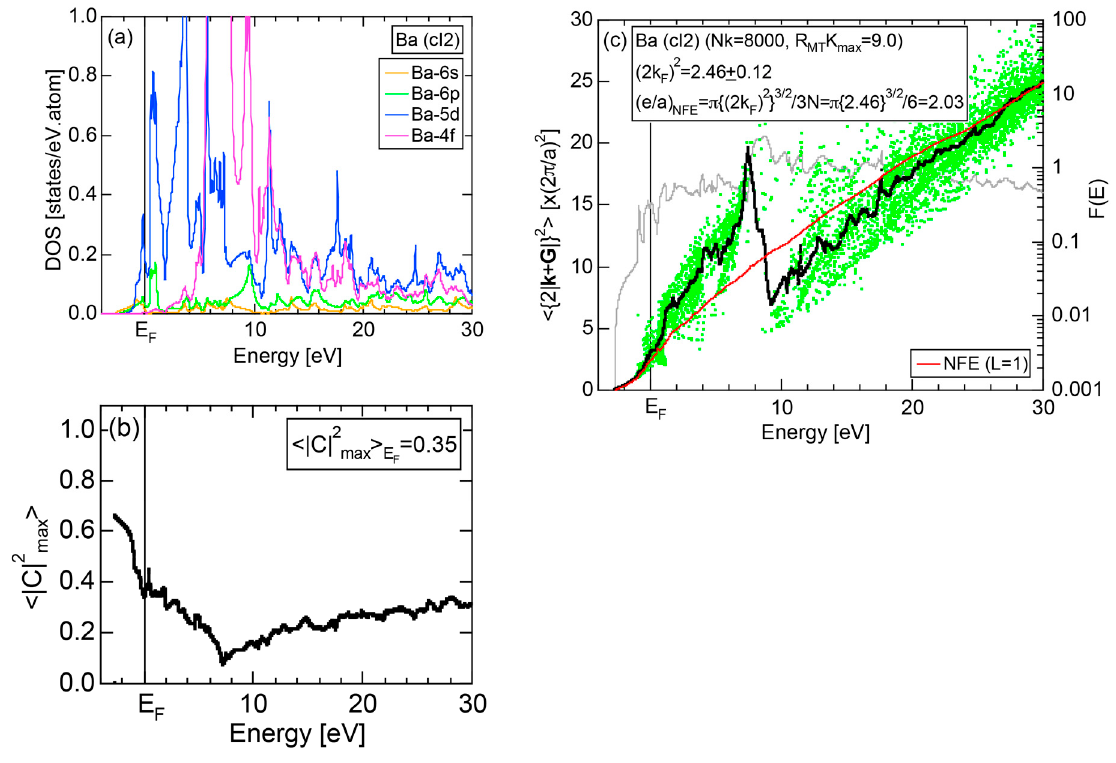
max2 and ( c ) Hume-Rothery plot for Ba (cI2). See E